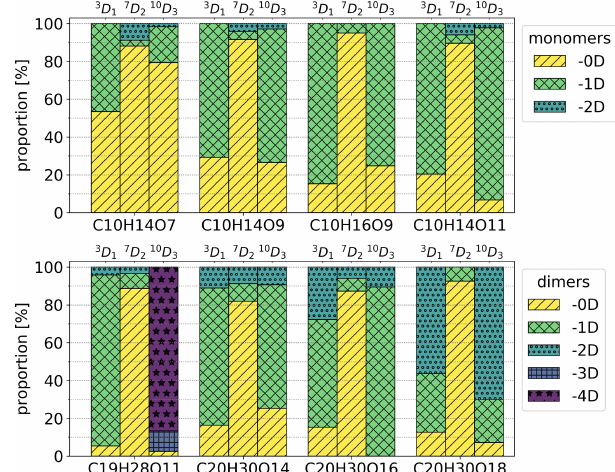
Figure 5. Example spectra using C 10 H 14 O 11 to show resulting HOM signals when using different selectively deuterated precur- sors. The nitrate cluster of C 10 H 14 O 11 (C 10 H 14 O 11 · NO − 372 Th. The colours show which selectively deuterated α -pinene is the precursor, and the values above the bars in matching colour tell how many deuterium atoms the HOMs have lost compared to the precursor. For example, the α -pinene with three deuterium atoms ( 10 D 3 , shown in blue) can form up to four different C 10 H 14 O 11 iso- topes in the spectrum. However, in the 10 D 3 precursor’s case there is no signal for C 10 H 14 O 11 without any deuterium atoms ( − 3D).